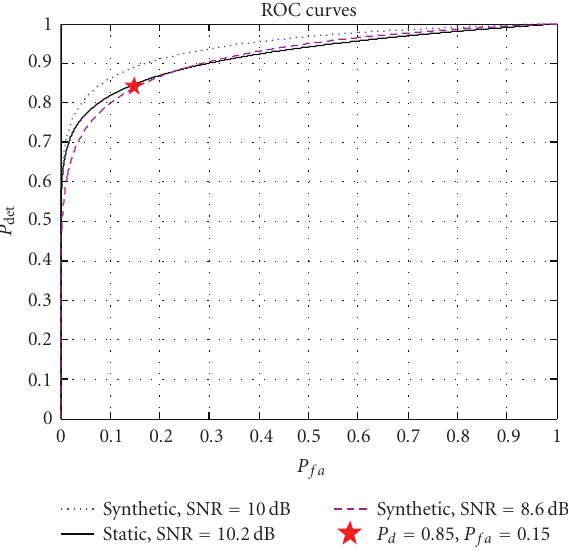
Figure 12: Measured ROC curves for static antenna and synthetic